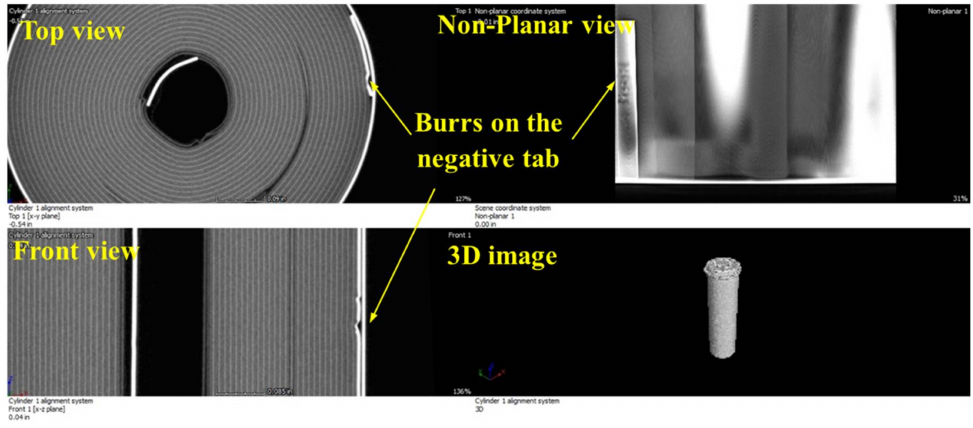
Figure 15. CT scan images near the negative tab of the sample